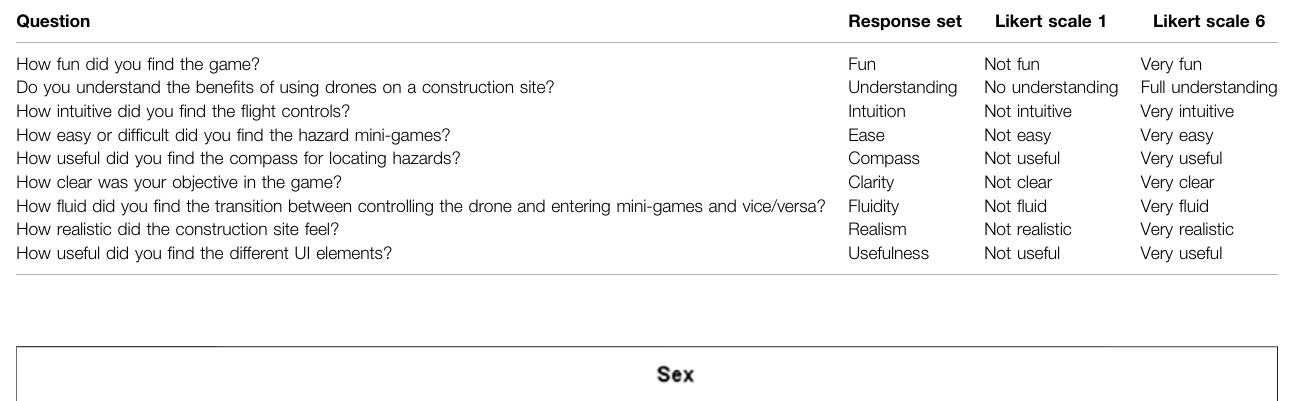
TABLE 3 | Likert Scale playtest questionnaire.